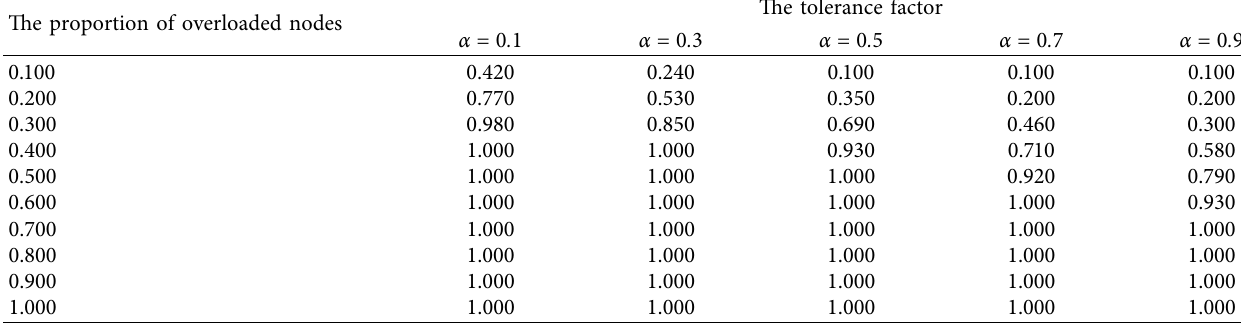
Table 6: The proportion of abnormal nodes (a).